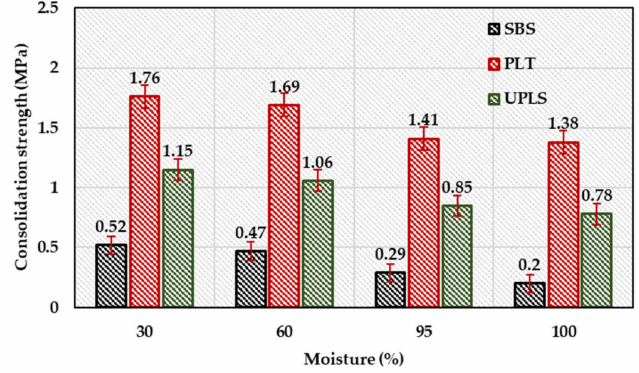
Figure 17. Consolidation strengths of the three waterproof coatings at di ff erent